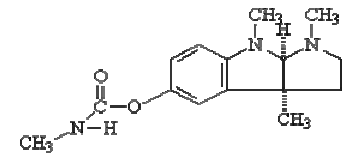
Figure 2 . Esarine (Physostigmine) An Figure 1. Atropine acetycholinesterase inhibitior (alkaloid)